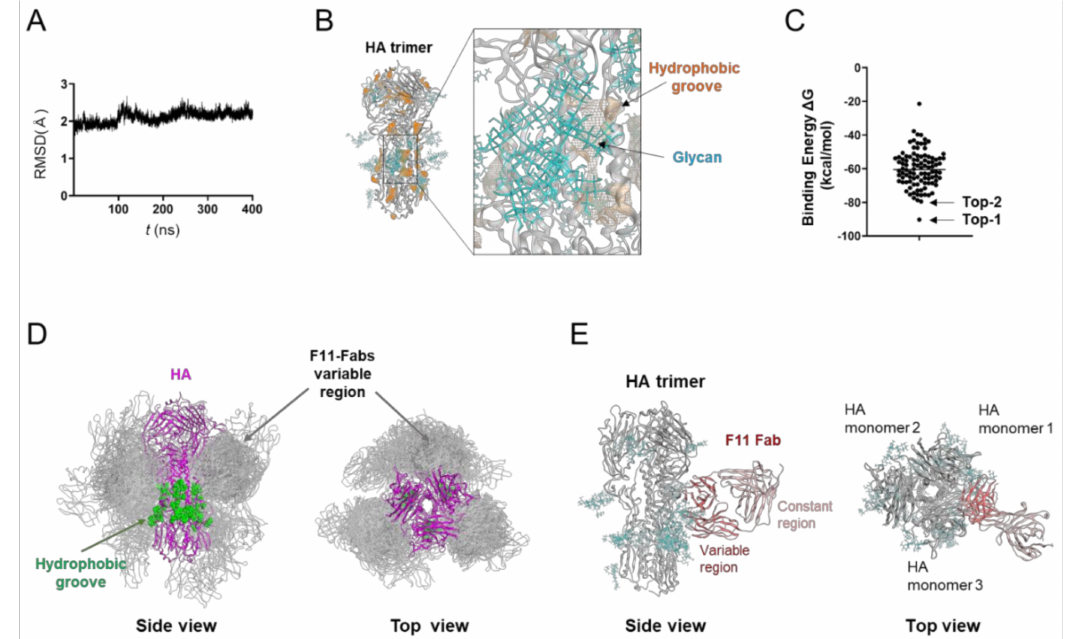
Figure 1. Molecular modeling of the complex of glycosylated HA trimer and F11 Fab fragment. A three-dimensional model of the unliganded, glycosylated HA trimer ectodomain of A/Narita/1/2009 (H1N1)pdm09 virus [19] was constructed by the homology modeling method using the Molecular Operating Environment (MOE) (Chemical Computing Group Inc., Montreal, QC, Canada), glycosylated using tools in GLYCAM-Web [21], and subjected to MD simulation using modules in the Amber 16 program package [23]. The HA trimer model in the equilibrium state under solution conditions was used for the docking simulations of the F11 Fab fragment using the Dock application of MOE [29,30]. ( A ) Root mean square deviation (RMSD) [23] between the structure of the initial HA structure and those at given time points of the MD simulation of glycosylated HA trimers calculated using the cpptraj module in AmberTools 16 as described previously [22]. ( B ) Side view of the HA trimer model at 400 ns of MD simulation. ( C ) Distribution of binding energies among the top 100 binding poses generated using the Dock application of MOE [29,30]. ( D ) Superposition of 100 docking poses. The purple region indicates the HA trimer. Green regions indicate the hydrophobic groove [50] in the HA trimer [53,54]. Grey regions indicate F11 Fab variable regions of the top 100 docking poses. Glycans attached on the HA trimer are not shown here in order to highlight the binding mode of the F11 Fab variable region. ( E ) The second highest ranked binding mode of F11 Fab (top-2 binding mode). Cyan branches indicate the high-mannose oligosaccharide Man 5 GlcNAc 2